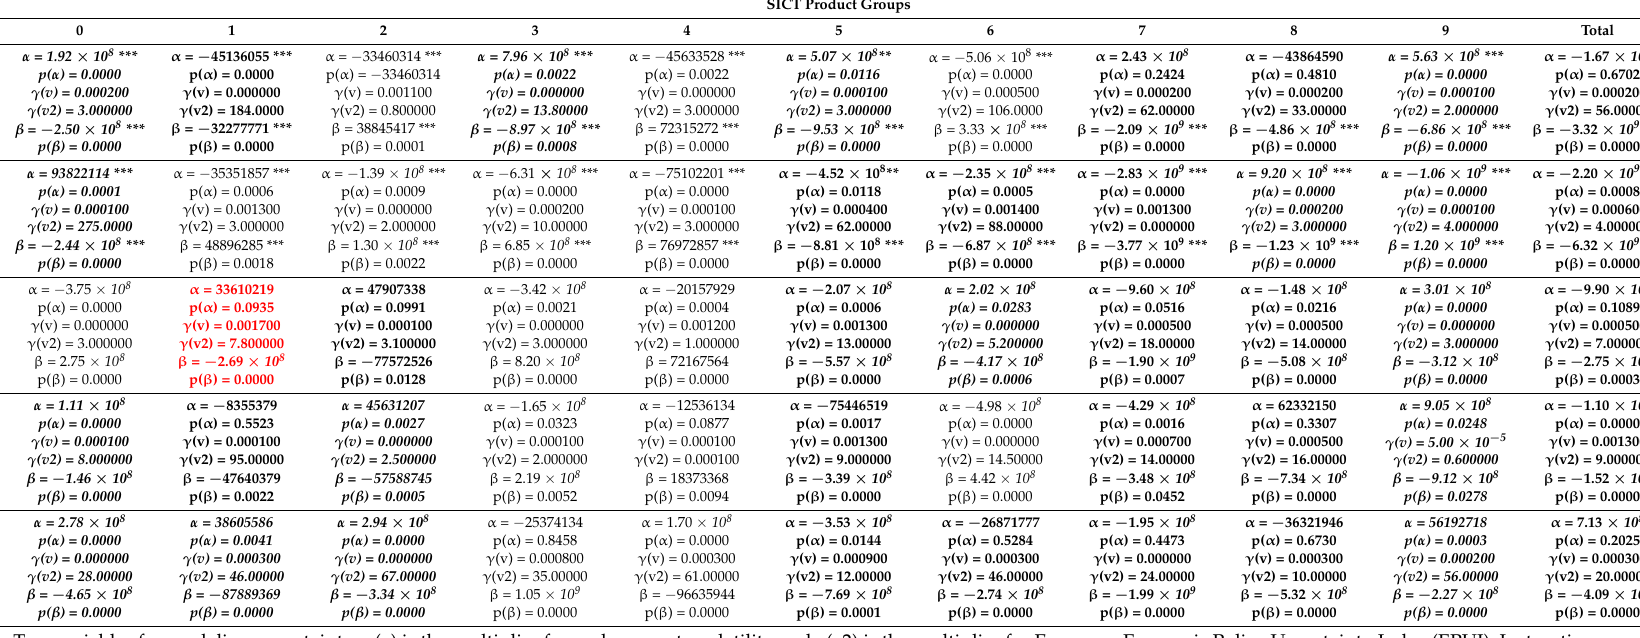
Table 1. Results for the regressions with a variable play area (estimated using exchange rate volatility and European